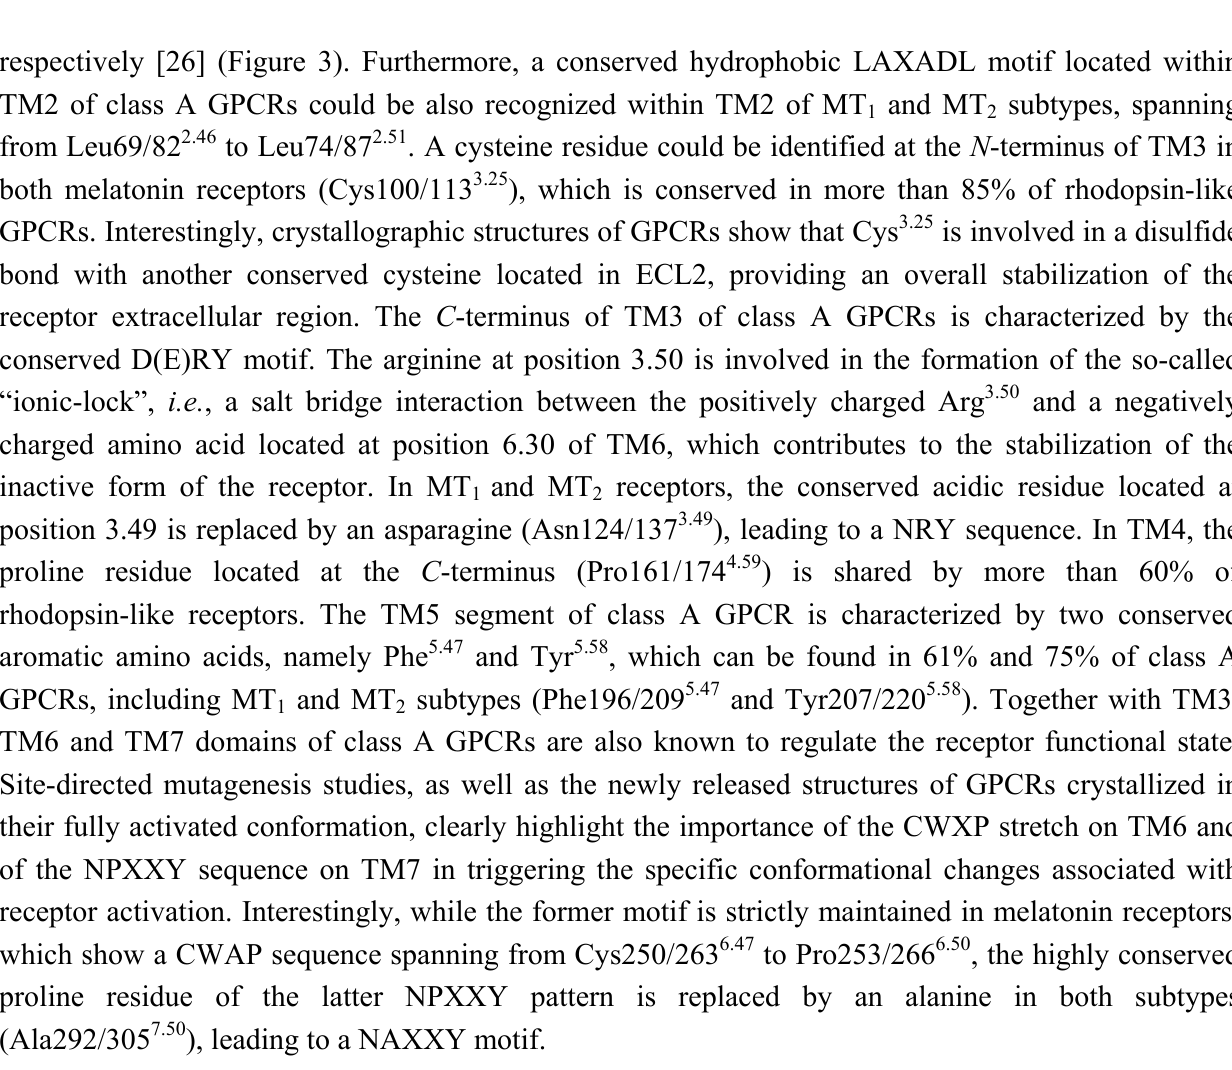
and MT receptors. Amino acids at 1 2